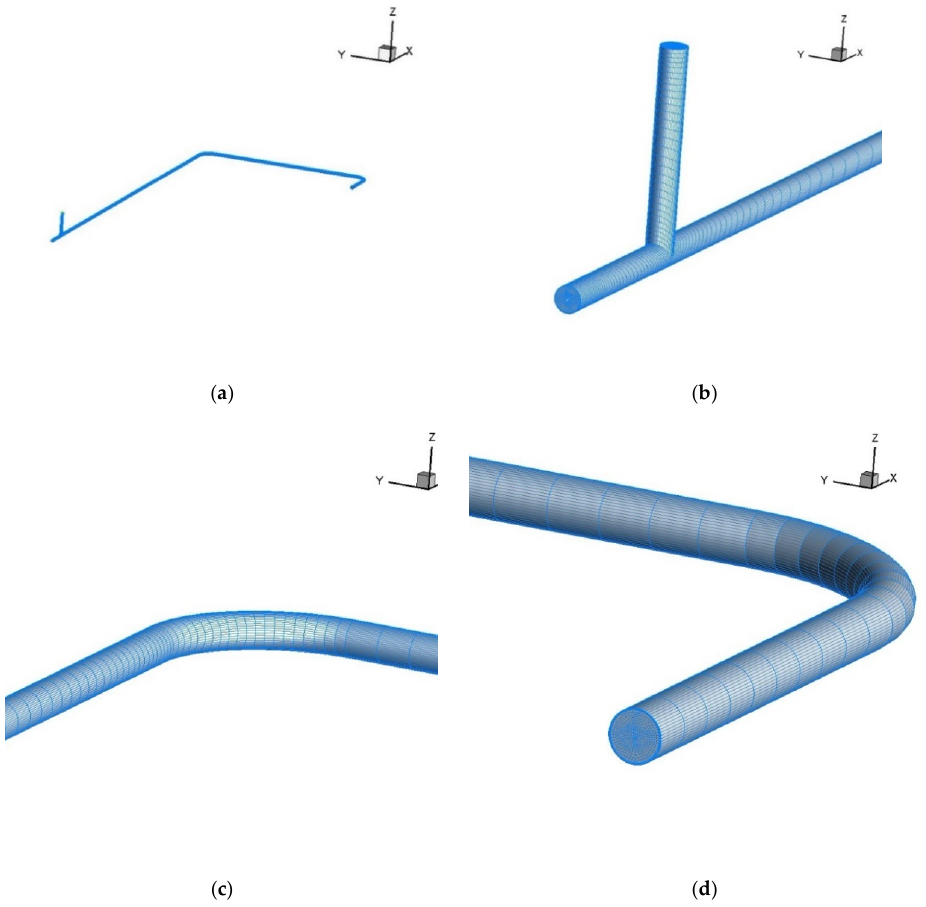
Figure 3. The three-dimensional schematic of the generated meshes from different viewpoints: ( a ) the entire simulated pipe section; ( b ) the air inlet and water inlet; ( c ) the elbow pipe; ( d ) the outlet.